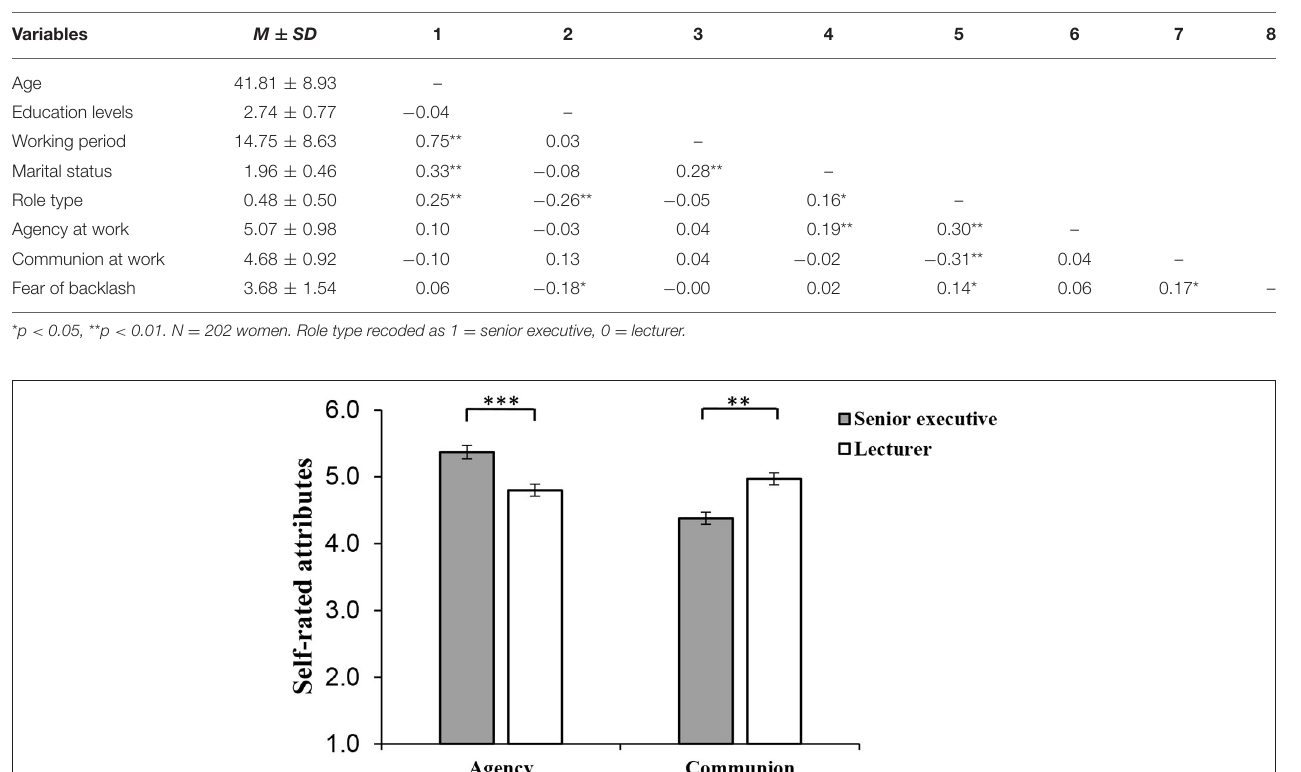
TABLE 4 | Descriptive statistics and correlations in Study 3.